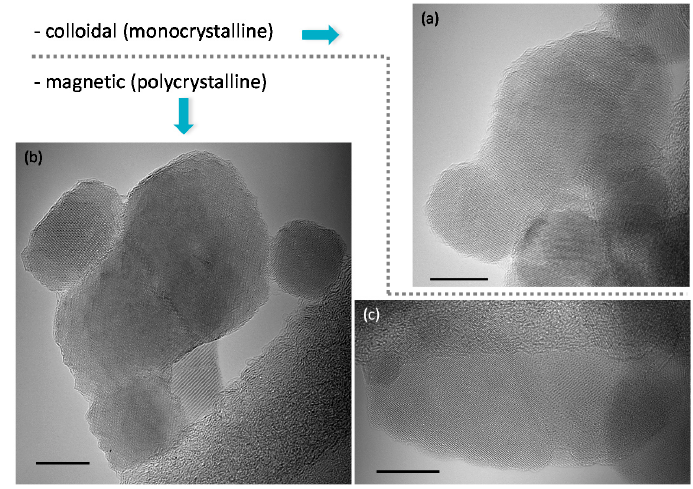
Figure 4. Representative TEM micrographs of monocrystalline secondary particles, SPs, ( a ) and polycrystalline SPs ( b , c ) separated by grey horizontal dashed line. The corresponding interaction (colloidal and magnetic interactions) and the type of SPs (monocrystalline and polycrystalline) caused by this interaction are indicated by the arrows. All scale bars are 10 nm.